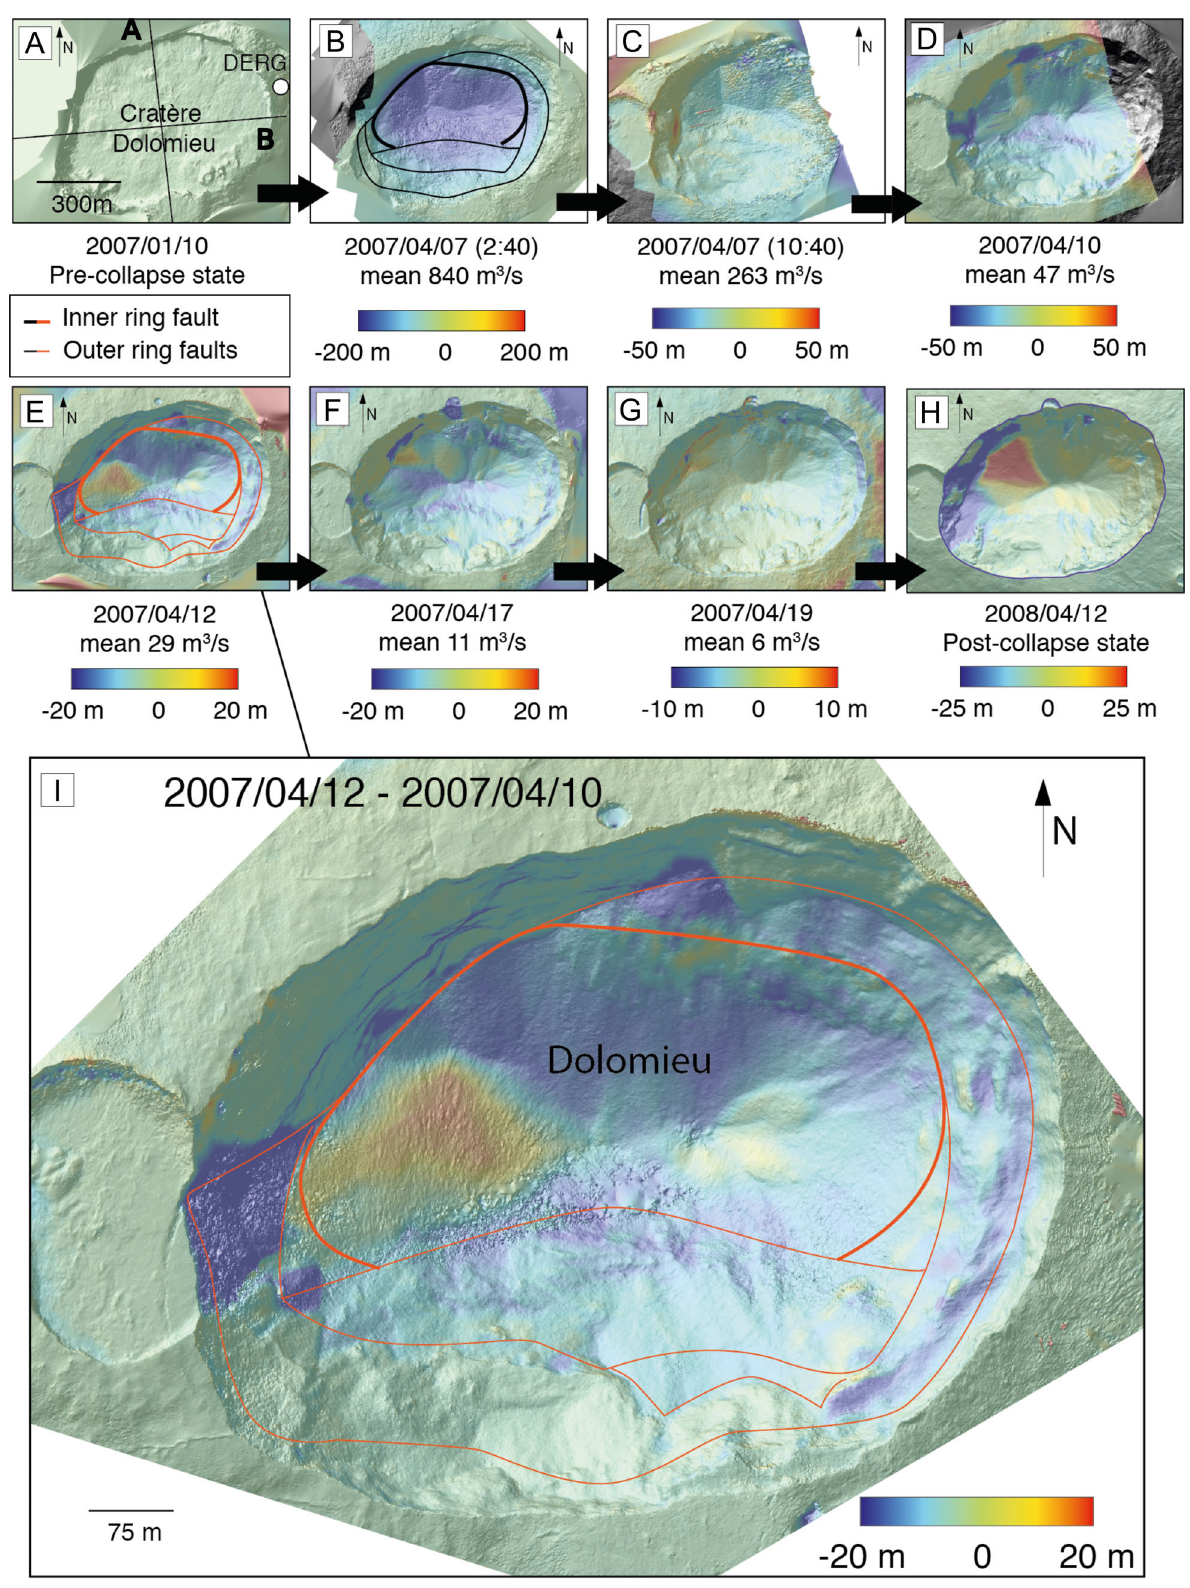
Figure 2: Evolution of subsidence inside the Cratère Dolomieu during and after the collapse, from vertical dif- ferences between consecutive DEMs. A and B on [A] are the locations of the cross-sections shown in Figure 3A, B. Rates are obtained by dividing the volume di ff erence by the time period between two acquisitions. The thick and thin red contours on [E] and [I] are the outlines of the IRFs (Inner Ring Faults) and ORFs (Outer Ring Faults), respectively, reported in Figure